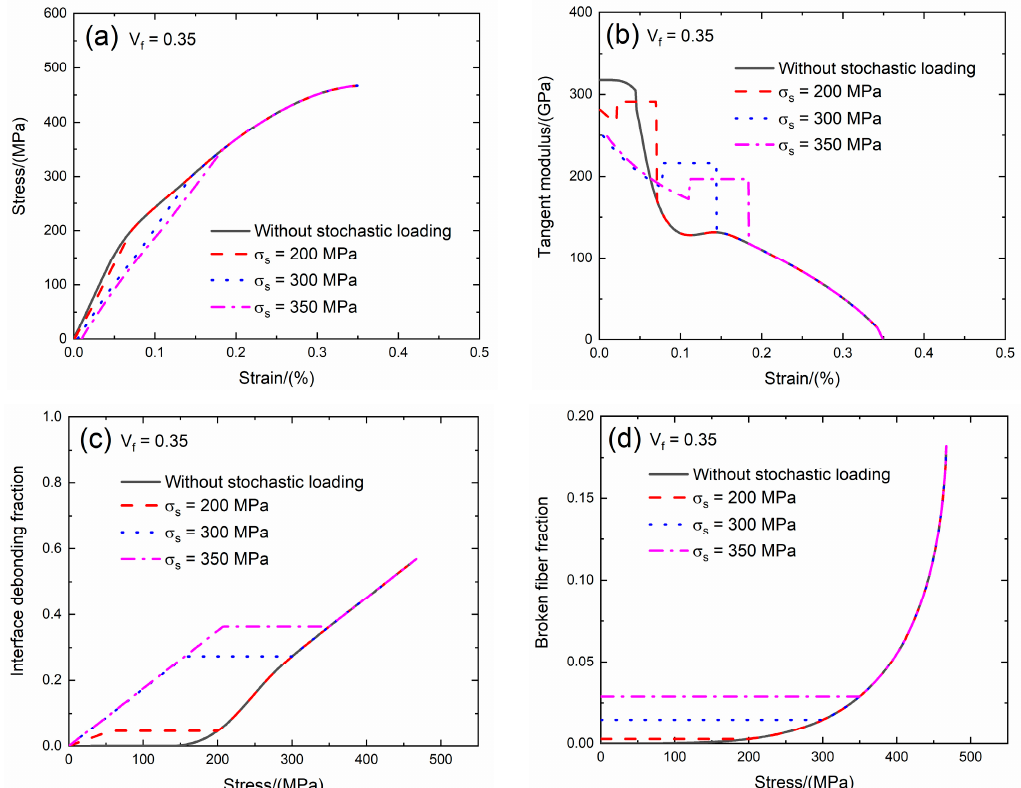
Figure 4. ( a ) The tensile stress–strain curves; ( b ) the tangent modulus versus strain curves; ( c ) the interface debonding fraction versus stress curves; and ( d ) the broken fibers fraction versus stress curves of SiC/SiC composite for conditions without stochastic loading and with stochastic loading of σ s = 200, 300 and 350 MPa when V f = 0.35. Table 1. The effect of the fiber volume ( V f = 0.3 and 0.35) on tensile stress–strain curve, tangent modulus, interface debonding fraction and broken fiber fraction of SiC/SiC composite subjected to stochastic loading of σ s = 200, 300 and 350 MPa.